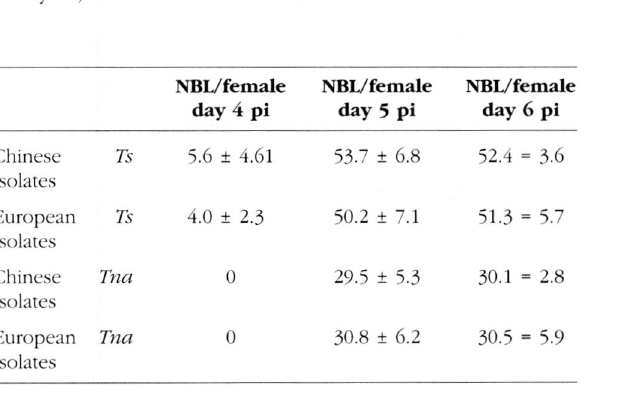
Table I. - Prolificity of Trichinella females in vitro. A comparison between Ts and Tna purified on days 4, 5 and 6 pi. The quantifi cation was done three days after purification of Ad. Ad purified on day 3 did not expelled